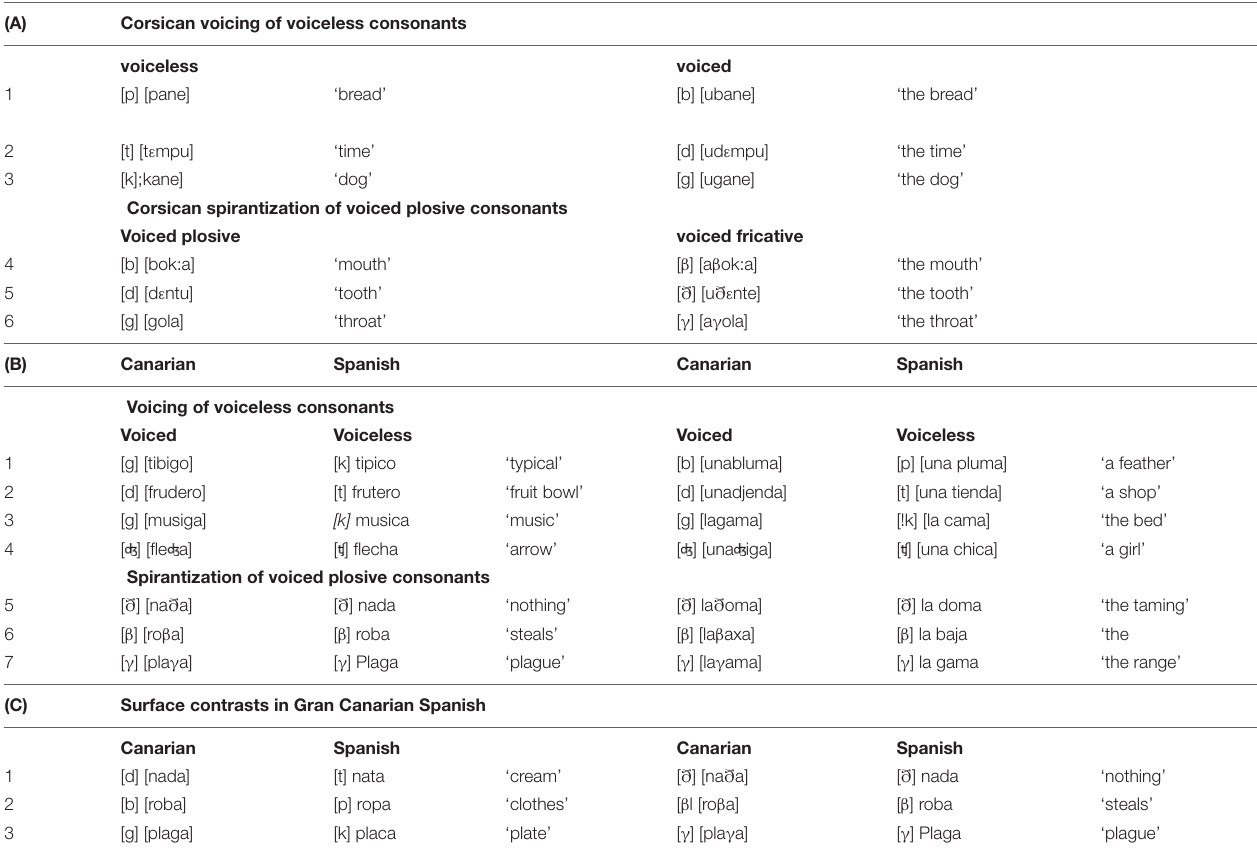
TABLE 2 | Examples of consonant